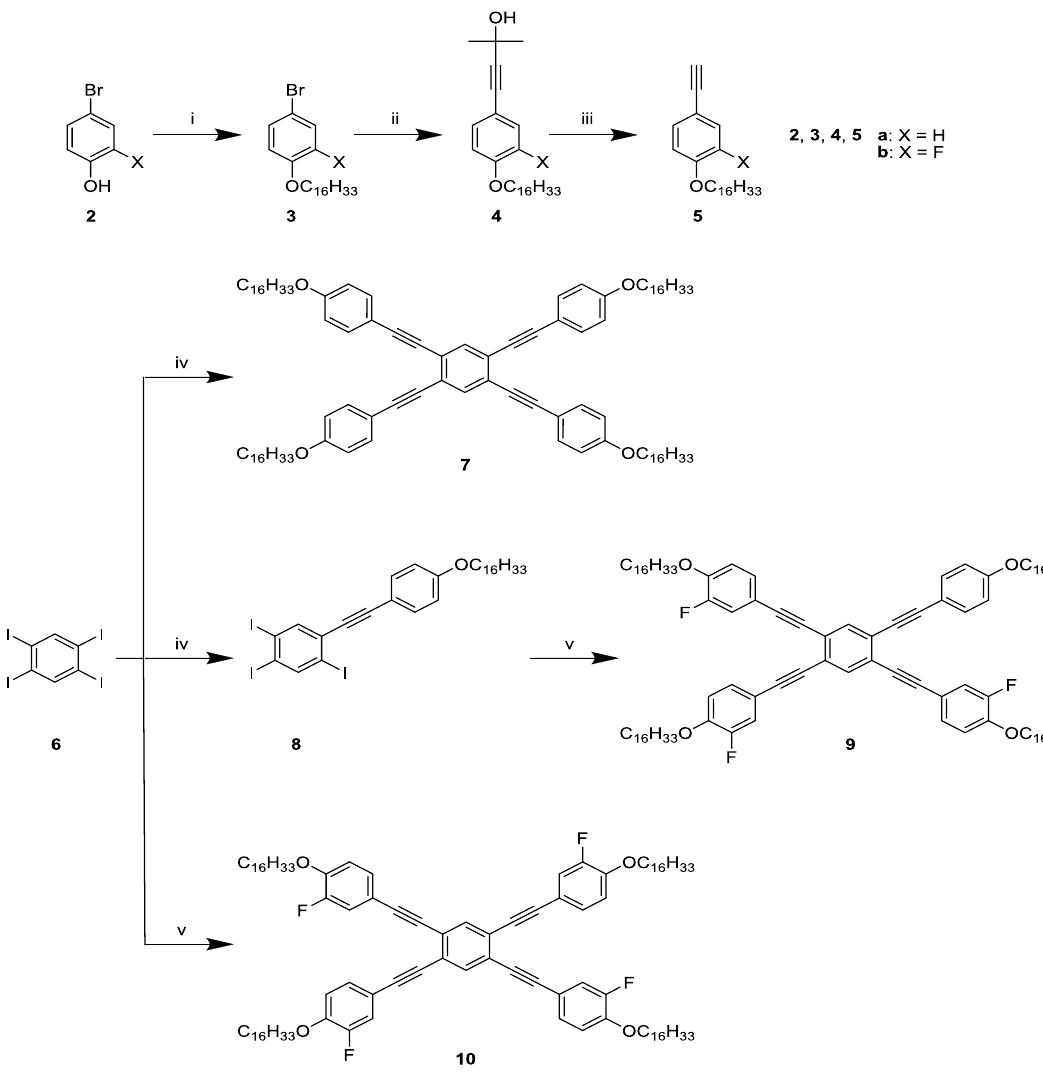
Figure 2. Synthesis of the non-fluoro OC (TPEB) ( 7 ), the trifluoro substituted TPEB ( 9 ) and the tetrafluoro substituted TPEB ( 10 ). Conditions: (i) RBr, K CO , KI, acetone, reflux, 24 h; (ii) Pd(PPh 2 3 2-methyl-3-butyn-2-ol, ( i -Pr) NH, 80 °C, 4 h; (iii) KOH, toluene, EtOH, reflux, 2 h; 2 (iv) 5a , Pd(PPh ) Cl , CuI, triethylamine, room temperature (r.t.), 12 h; (v) 5b , 3 2 2 Pd(PPh ) Cl , CuI, TEA, r.t., 12 3 2 2